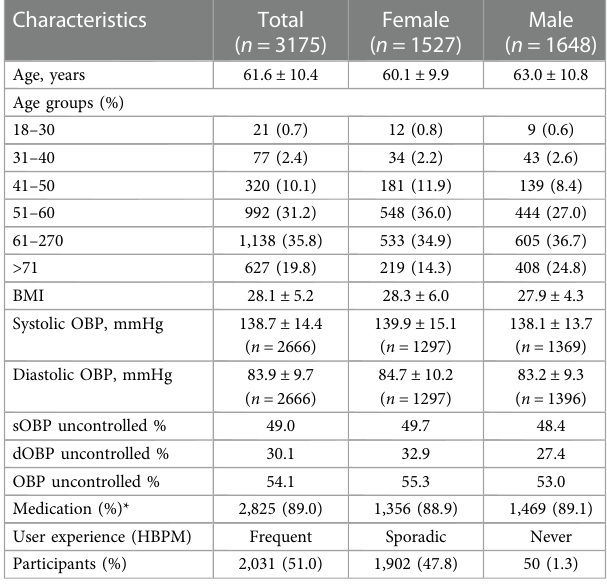
TABLE 1 Baseline characteristics of users with self-reported